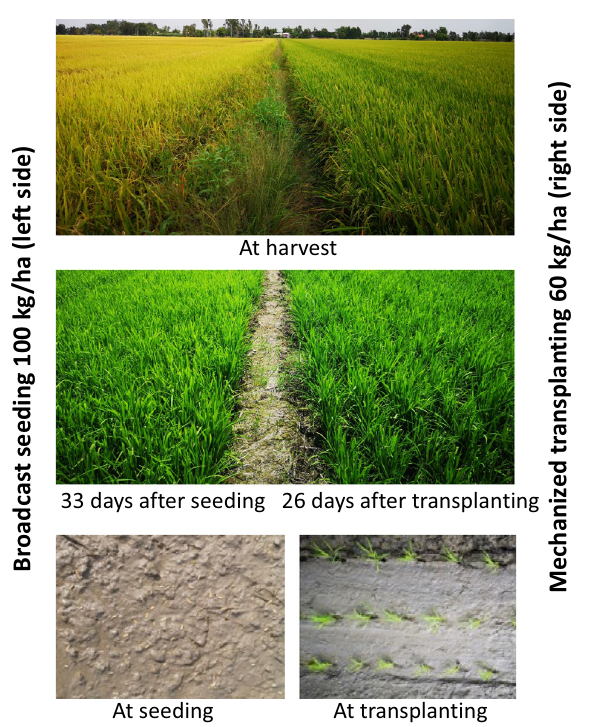
Figure 5. Comparisons in experimental fields of rice sown using a blower seeder (broadcast seeding, on left) or mechanized transplanting (on the